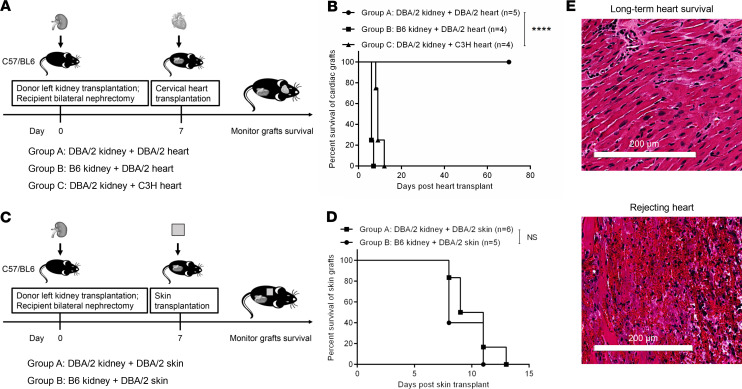
Survival of cardiac and skin grafts in cotransplant recipients.(A) Schematic representation of experimental design in kidney and heart cotransplantation. Kidney grafts were first transplanted in recipients that have undergone a bilateral nephrectomy, and cardiac allografts were then cervically implanted into the recipients 7 days after kidney transplant. (B) Survival curves of cardiac grafts for each group are shown (group A, DBA/2 kidney + DBA/2 heart, n = 5; group B, DBA/2 kidney + DBA/2 heart, n = 4; group C, DBA/2 kidney + C3H heart, n = 4). Graft survival curves were constructed by the Kaplan-Meier method. ****P < 0.0001, log-rank test. (C) Schematic representation of experimental design in kidney and skin cotransplantation. Kidney grafts were first transplanted into recipients that have undergone bilateral nephrectomy, and 7 days later, skin grafts were placed on the recipients. Survival of both grafts was monitored. (D) Survival curves of skin grafts in each group are shown (group A, DBA/2 kidney+ DBA/2 skin, n = 6; group B, B6 kidney+ DBA/2 skin, n = 5). Graft survival curves were constructed by the Kaplan-Meier method (log-rank test). (E) Representative images of DBA/2 heart allografts from accepted grafts (group A, top) and rejected grafts (group B, bottom) in B. Rejected heart allografts showed marked interstitial hemorrhage and myocyte necrosis. Scale bars: 200 μm.